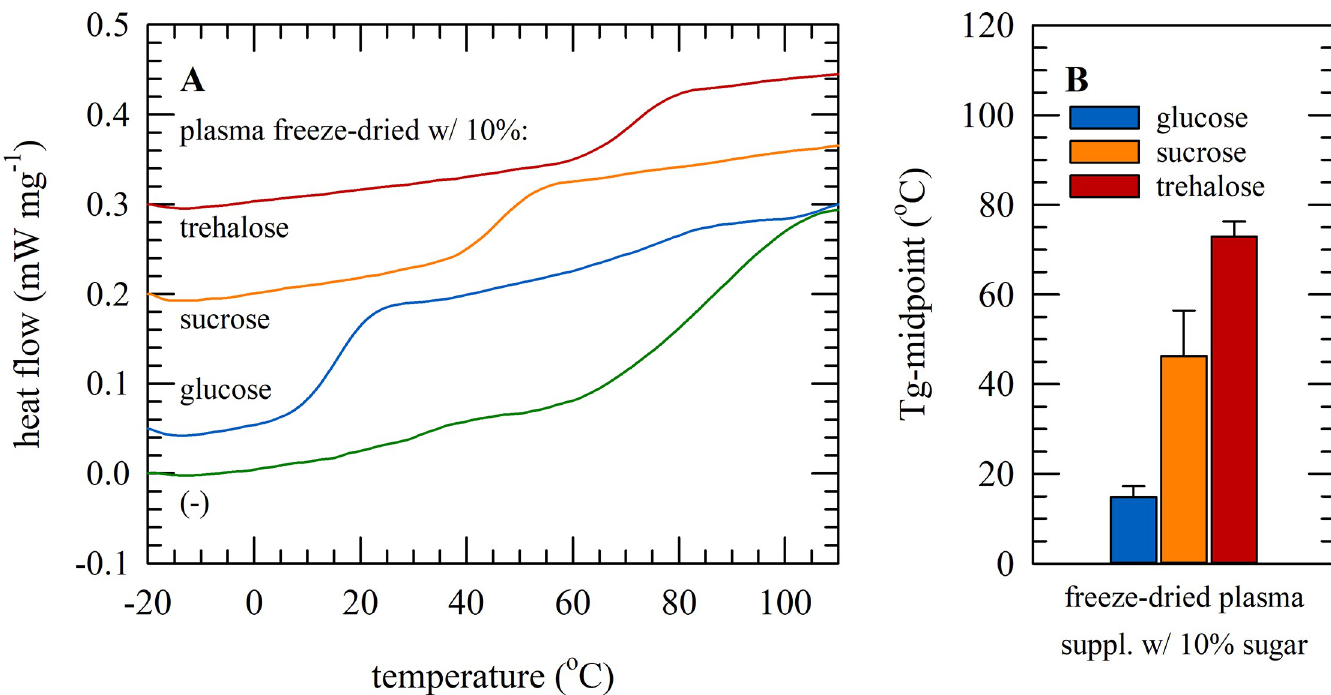
Fig 1. Glass transition temperatures of freeze-dried plasma samples. DSC thermograms of plasma samples that were freeze-dried without protectants (green), or freeze-dried with 10% glucose (blue), sucrose (orange), or trehalose (red). Representative thermograms are shown (A). Tg-values were determined as the midpoint of the temperature ranges were glass transition occurred. Measurements were done in triplicate, and mean values ± standard deviations are presented (B).